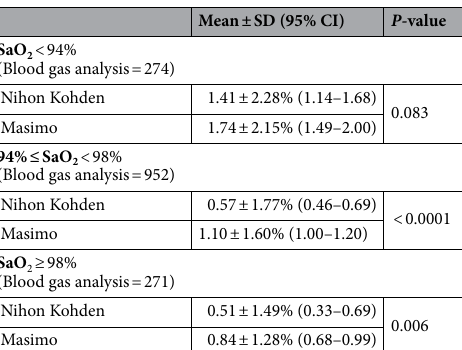
Table 3. Differences in SpO 2 measurements between pulse oximeters. CI confidence interval, SaO 2 arterial oxygen saturation, SD standard deviation, SpO 2 pulse-oximetric oxygen saturation.